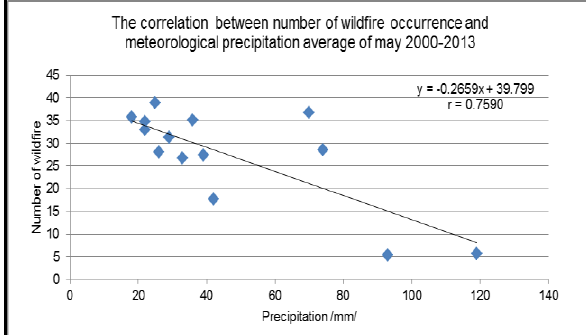
Figure 7. Result of linear regression between wildfire and climate data